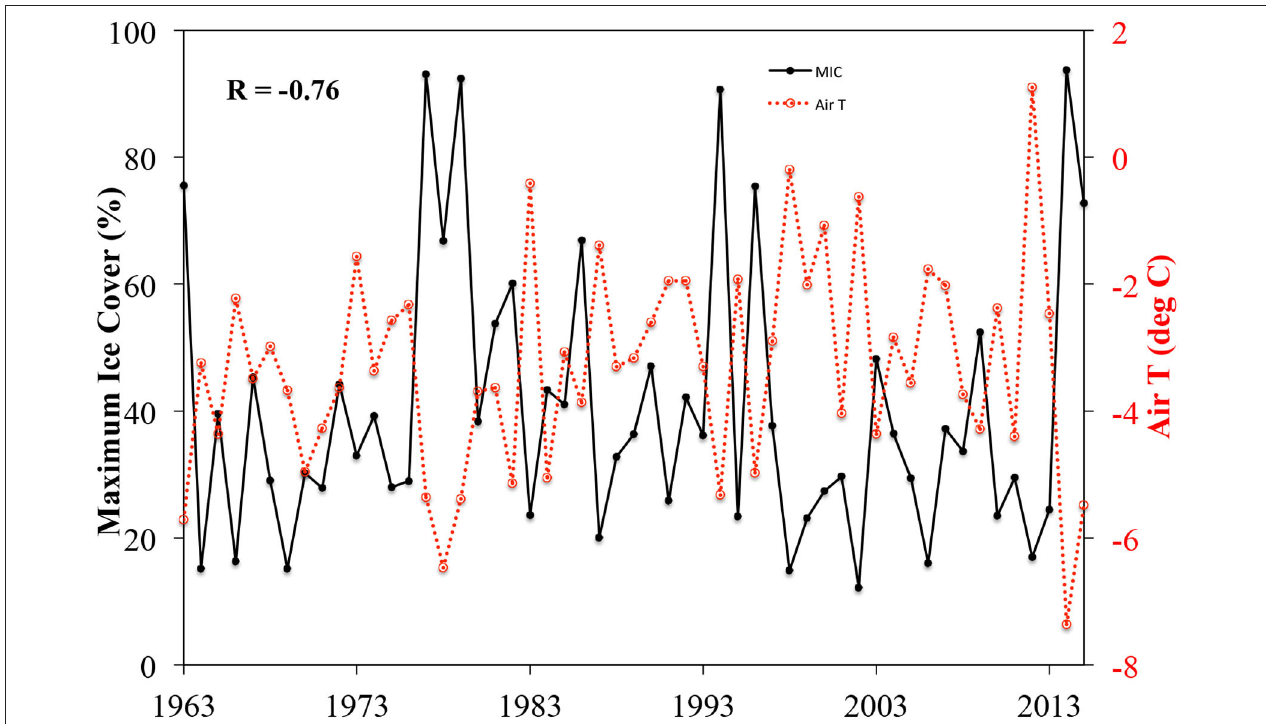
FIGURE 9 | The temporal variation in the maximum ice cover (MIC) (%) (solid black line) and surface air T ( ◦ C) (dashed red line) in the Lower Peninsula of Michigan.